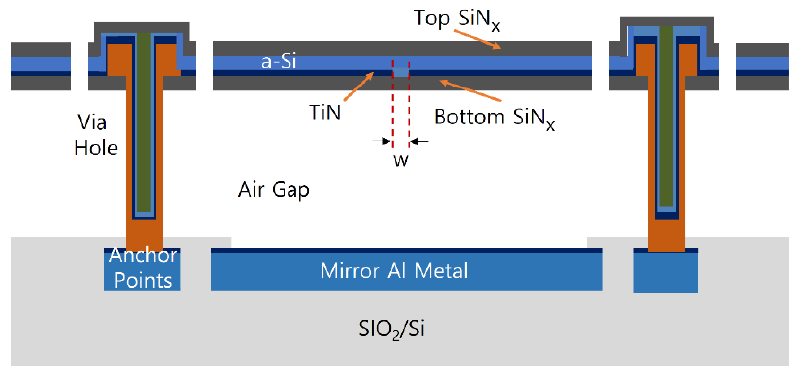
Figure 1. Schematic cross-sectional view of the a-Si microbolometer unit pixel. Here, SiN x is silicon nitride deposited by the PECVD, and w denotes the pattern spacing of the TiN absorption layer.